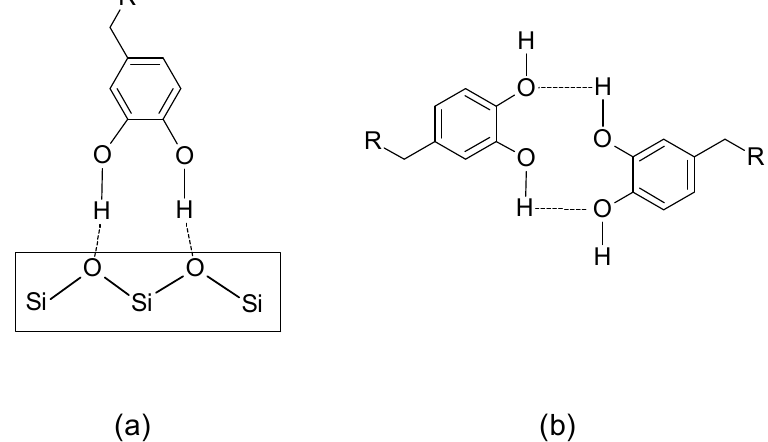
Scheme 7. Generic hydrogen bonding motifs of catechol hydroxyls contributing to adhesion (( a ): simplified aluminosilicate substrate) and self-healing (( b ): complementary hydrogen bonding with a catechol partner and alternate donor-acceptor function).